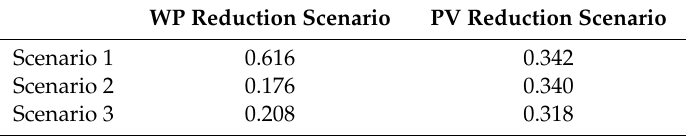
Figure 8. Reduced WP output scenarios ( a ) and PV output scenarios ( b ). Table 1. The probability of the WP scenarios and PV scenarios reduced.